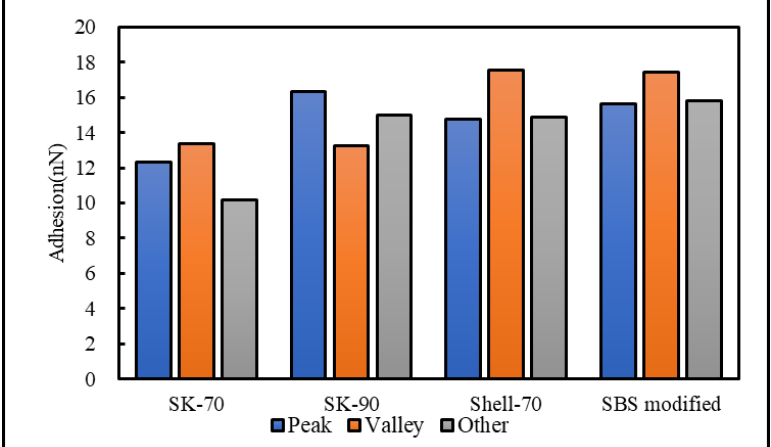
Figure 21. Adhesion between the probe and the different asphalts doped with RAA in the different regions.